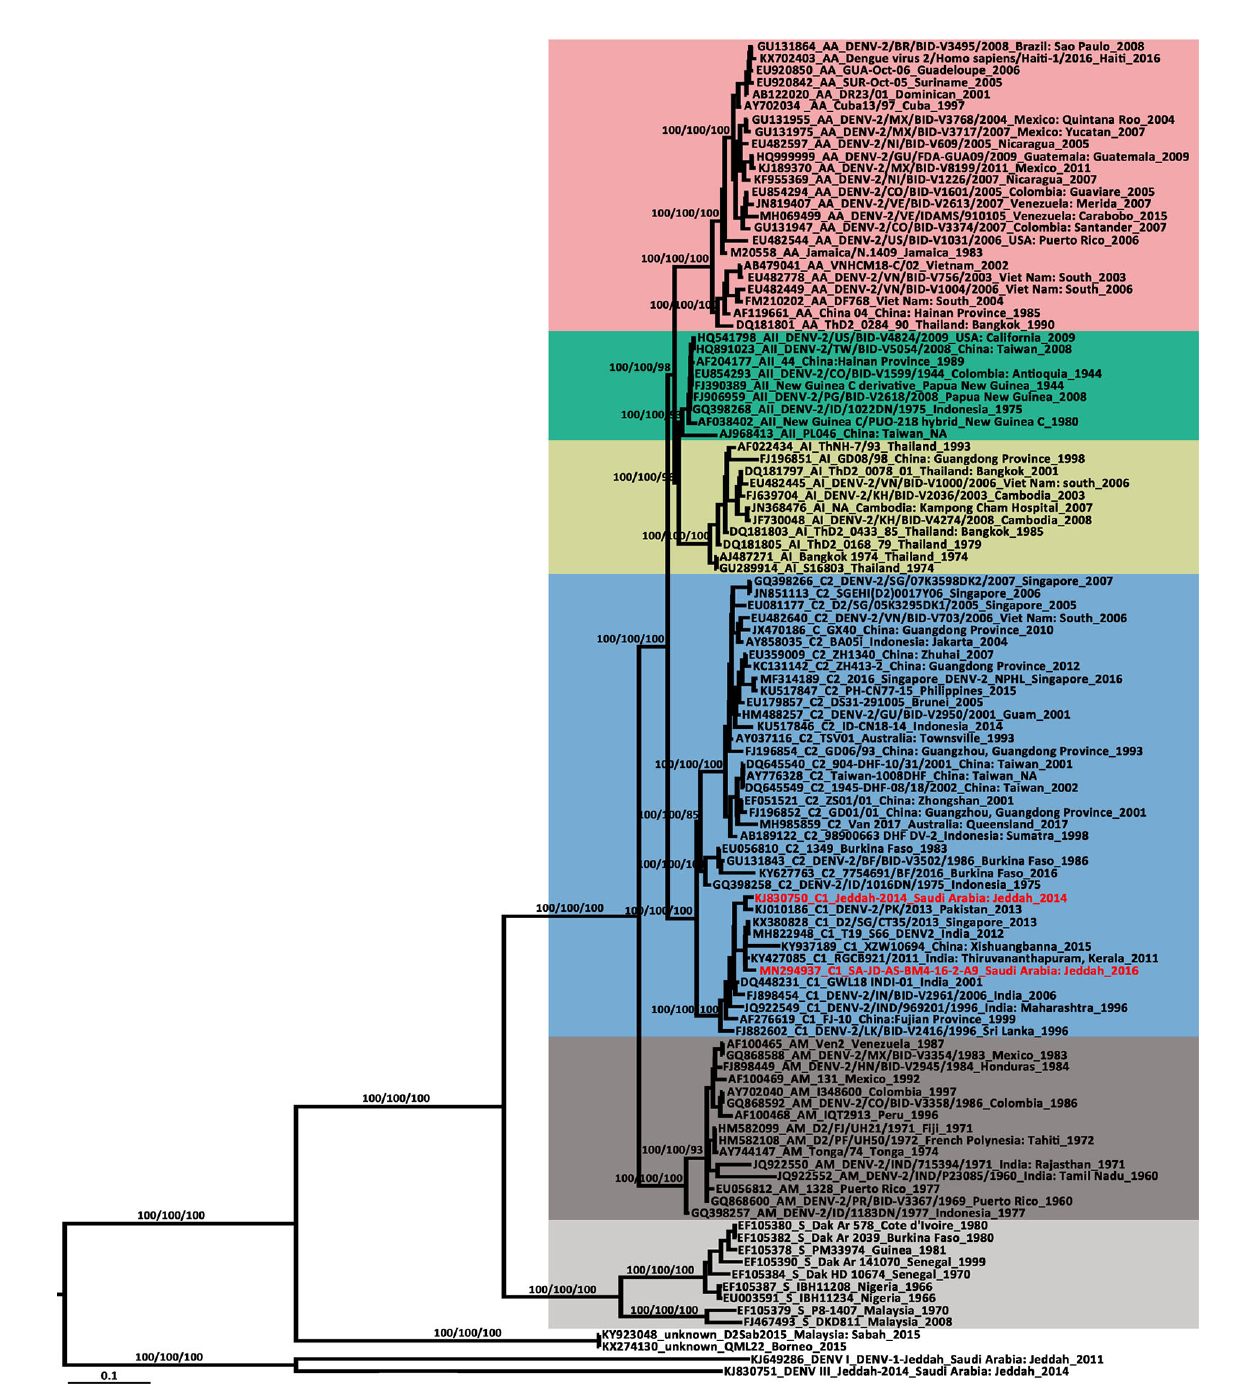
FIGURE 3 | Phylogenetic tree generated by Bayesian analysis of dengue virus 2 (DENV-2) complete genome. The GenBank accession number, virus genotype, strain, collection country and year are noted. The DENV-2 sequences from Saudi Arabia are marked in red. Bootstrap values (1,000 replicates, not shown for less than 75%) of Bayesian analyses, maximum likelihood and neighbor-joining are shown above the main lineages. The scale-bar indicates 0.1 substitutions per site. Sequences referable to the same genotype are shaded with the same colors in the tree. AA, American/Asian; AI, Asian 1; AII, Asian 2; AM, American; C, Cosmopolitan; S,